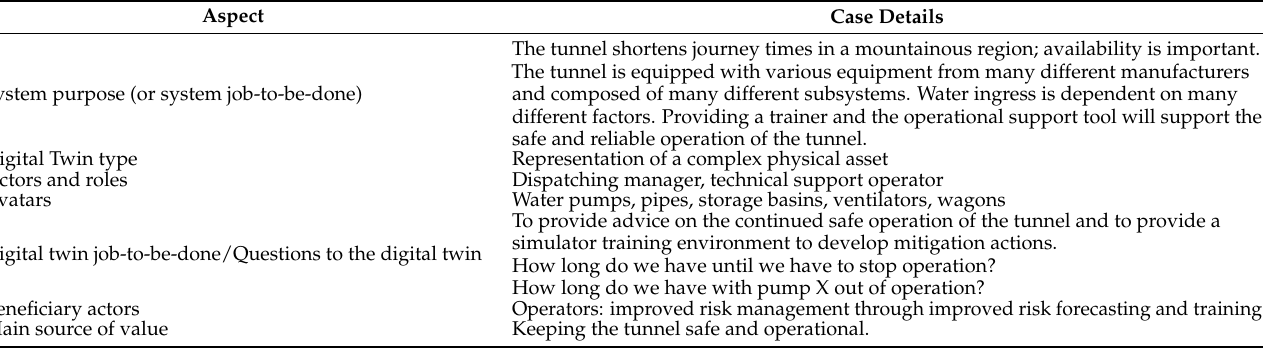
Table A10. Case 8—tunnel drainage system advisor.